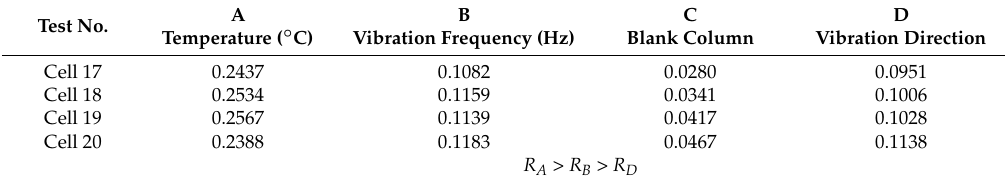
Table 15. The range analysis of the discharge capacity of the cells